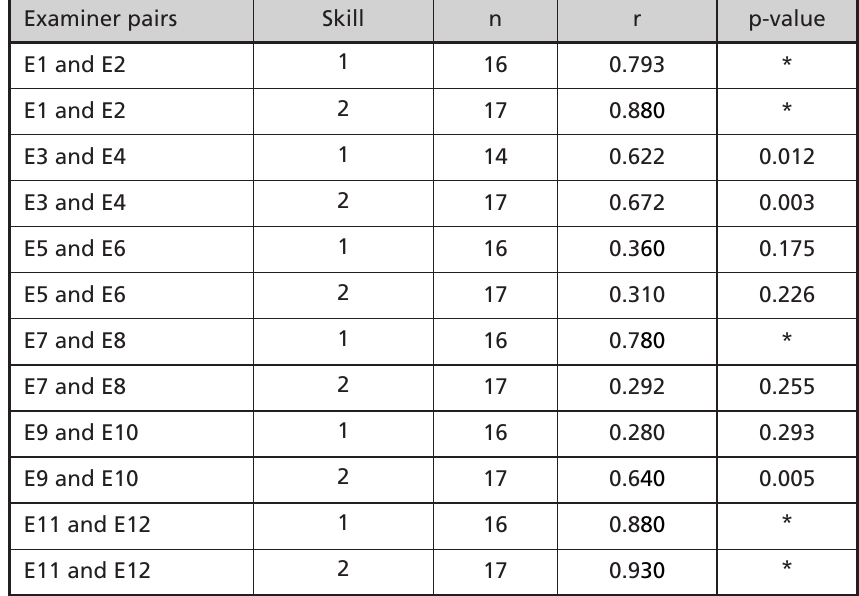
Table 4: Correlations for two examiners when examining the same skill at the same station Examiner